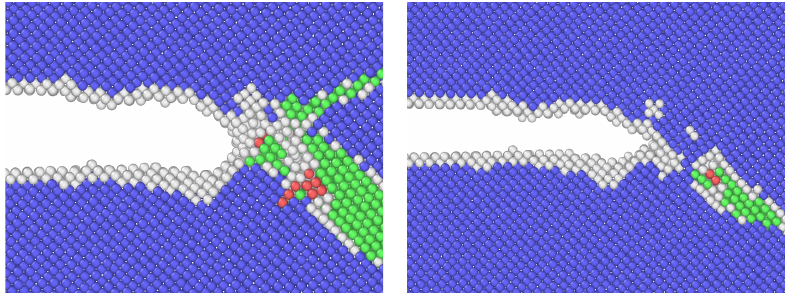
Figure 3. Various crack tip geometries. The colouring is presented according to common neighbour analysis. The blue colour indicates bcc, whereas the green notates fcc, and the red indicates the hcp iron structure. Particles belonging to an unidentified structure are visualised in